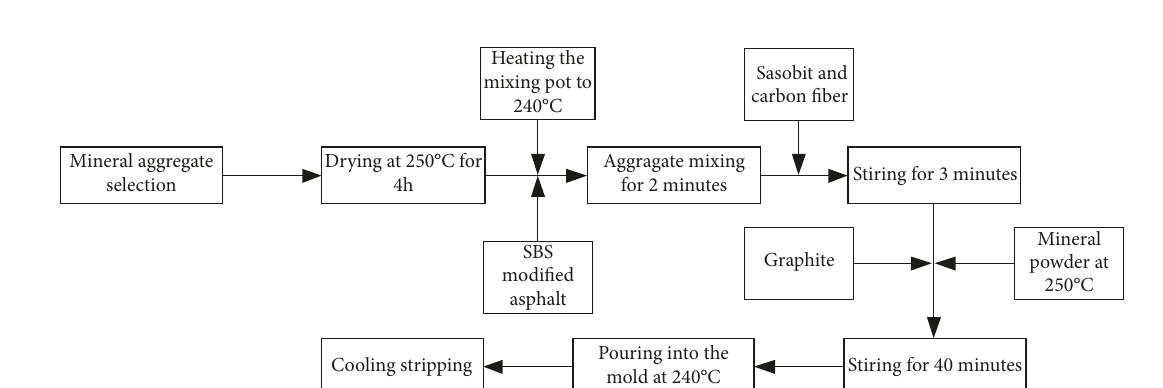
Figure 3: Preparation process of conductive gussasphalt